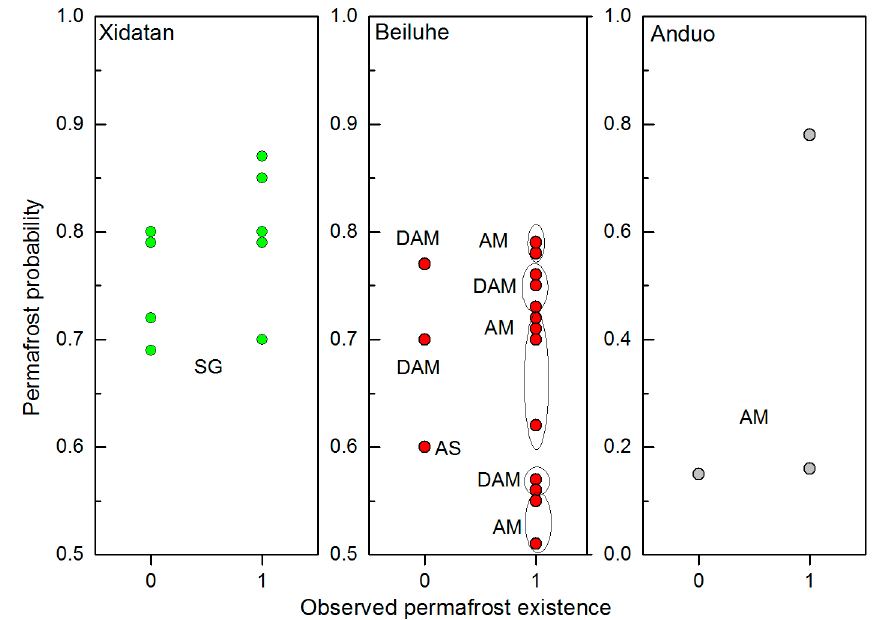
Figure 6. Plot of model variability in Xidatan, Beiluhe, and Anduo. SG = Sparse grassland, AM = Alpine meadow, DAM = Degrading alpine meadow, AS = Alpine steppe.